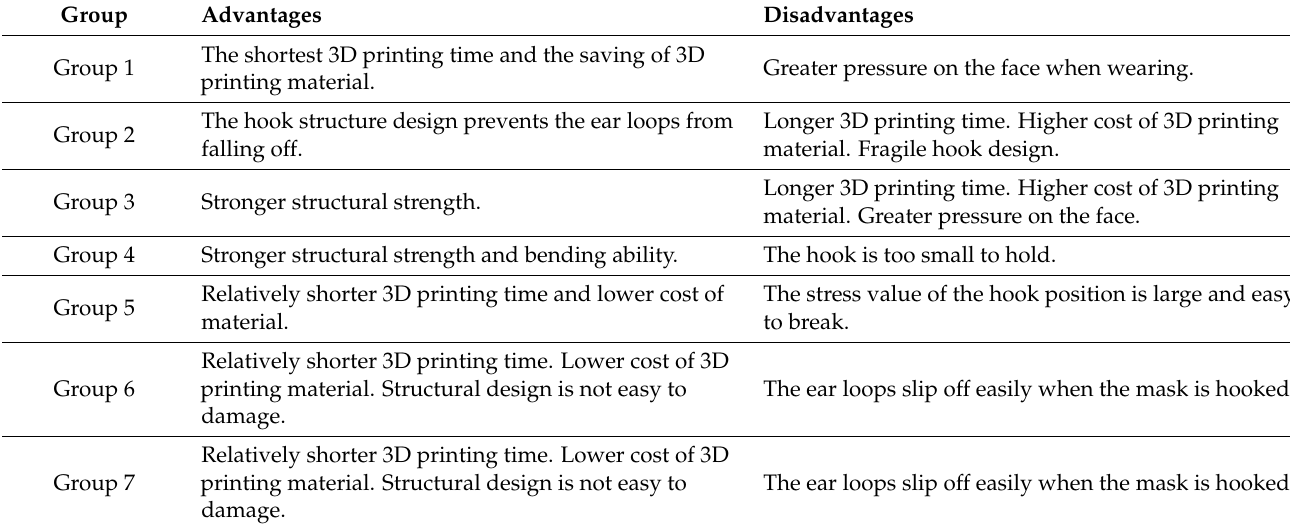
Table 5. The advantages and disadvantages of the SMTRBs in each